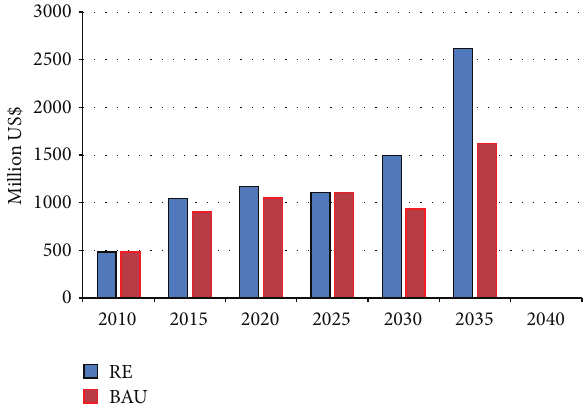
Figure 5: Investment costs comparison between BAU and RE scenarios.